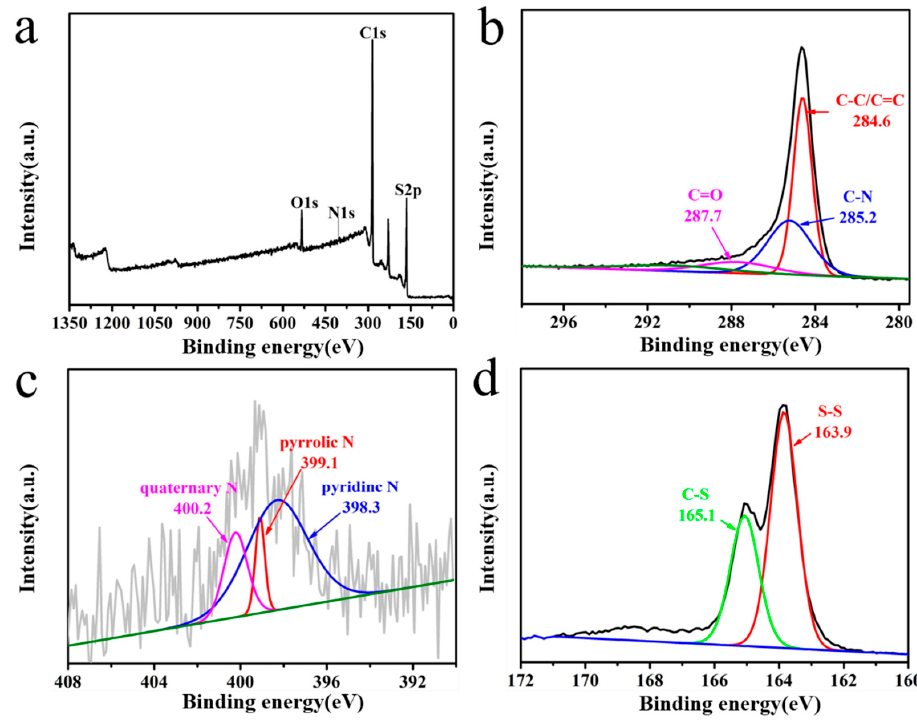
Figure 4. XPS spectrum of RCS composite materials. ( a ) XPS spectra of surface composition of RCS sample, ( b ) C1s, ( c ) N1s, and ( d ) S2p.